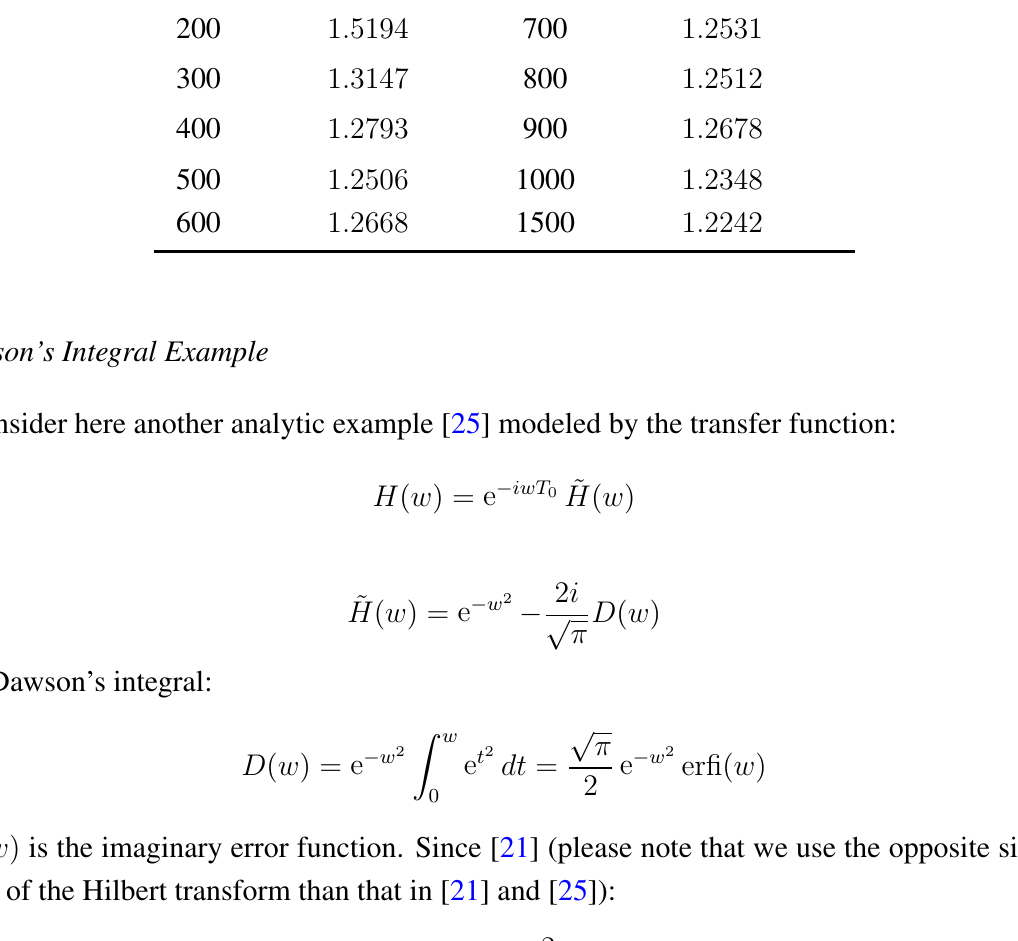
(in ns) in the transmission line example using extrapolations 0 = 1 . 25 ns, averaged value T ( aver ) 0